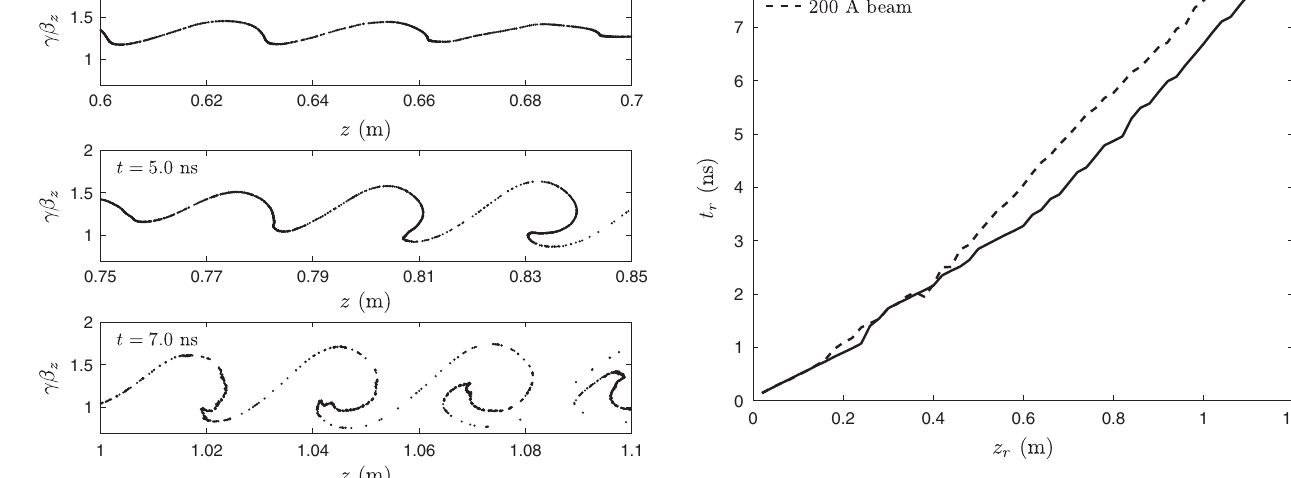
FIG. 21. Longitudinal phase space evolution for a 50 A beam with (cid:1) ¼ 1 showing phase trapping of beam electrons and the onset of synchrotron oscillations.